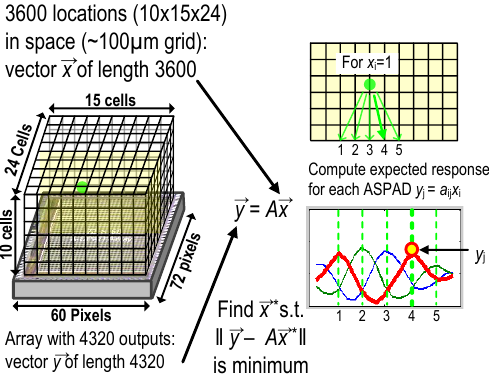
Figure 15. Illustration of 3D localization method based on angular